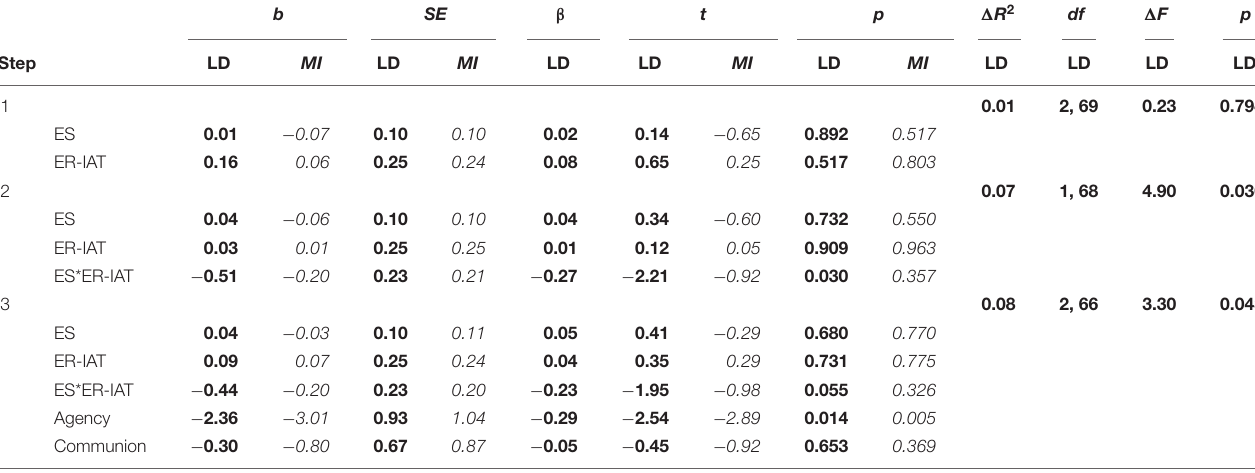
TABLE 9 | Results of the hierarchical multiple regression for Model 2b using LD and MI.